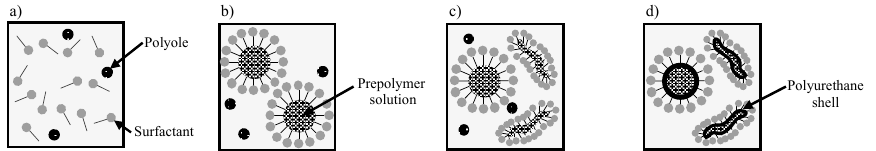
Figure 3. Schematic illustration of the formation of mixed capsules with spherical and fibrous shape, containing the healing agent. ( a ) Polyol and surfactant solution. ( b ) Formation of prepolymer micelles by dripping prepolymer solution with high viscosity into ( a ). ( c ) Formation of spherical and fibrous micelles by agitation at a low speed. ( d ) Formation of spherical and fibrous capsules consisting of polyurethane shell and self-healing agent content.